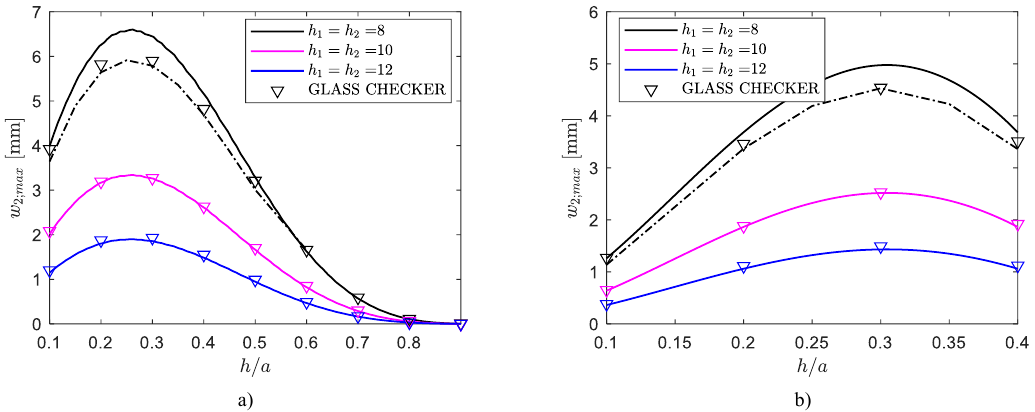
Fig. 13 Triangular DGU, maximum deflection of plate 2 for DGUs under a) line distributed load and b) concentrated load. Comparisons among BAM approach (continuous line), BAM approach + FEM analyses (dashed-dotted line), and Glass Checker